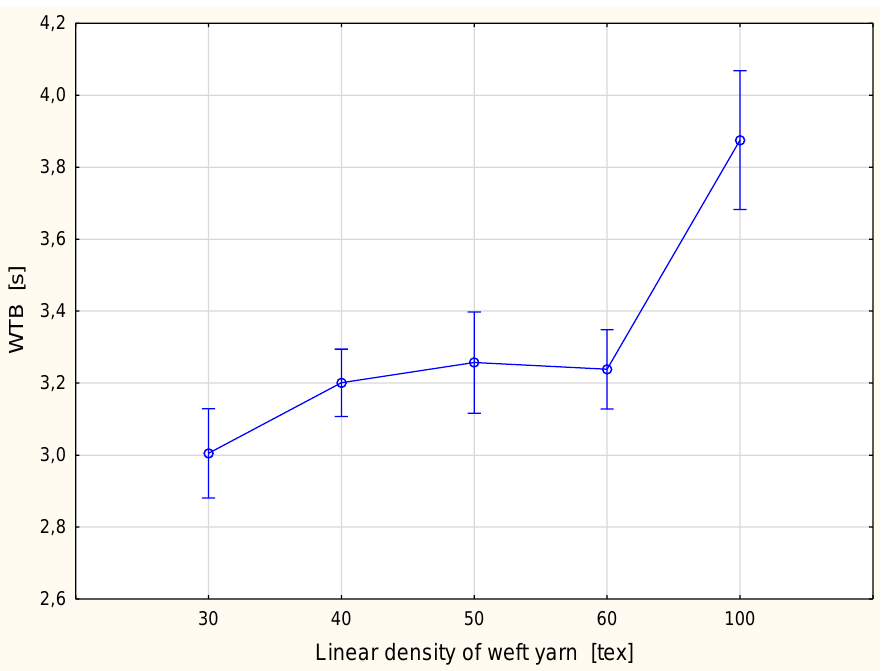
Figure 3. Wetting time for the bottom fabric surface vs. linear density of the weft yarn. The WTT and WTB are the time periods in which the top and bottom surfaces of the fabric started to become wet after the test commenced. They are defined as the time in second (s) [33]. The longer the wetting time was, the worse the performance of the fabric from the aspect of wettability. The shortest wetting time was for the fabric variant with the 30 tex weft yarn. For the top surface, the value of the WTT was 2.84 s, and for the bottom surface the WTB was 3.00 s. The longest wetting time for both sides occurred for the fabric variant with the 100 tex weft yarn: the WTT was 3.69 s, and the WTB 3.88 s. It was also found that the wetting time for fabric variants with the weft yarns 50 tex and 60 tex was at the same level. For the fabric variant with the 50 tex weft yarn, the WTT value was 3.23 s and the WTB was 3.26 s, whereas for the variant with the 60 tex weft yarn the WTT was 3.19 s and the WTB 3.24 s. For both surfaces, inner and outer, the tendencies were the same. The wetting time increased with an increase of the linear density of weft